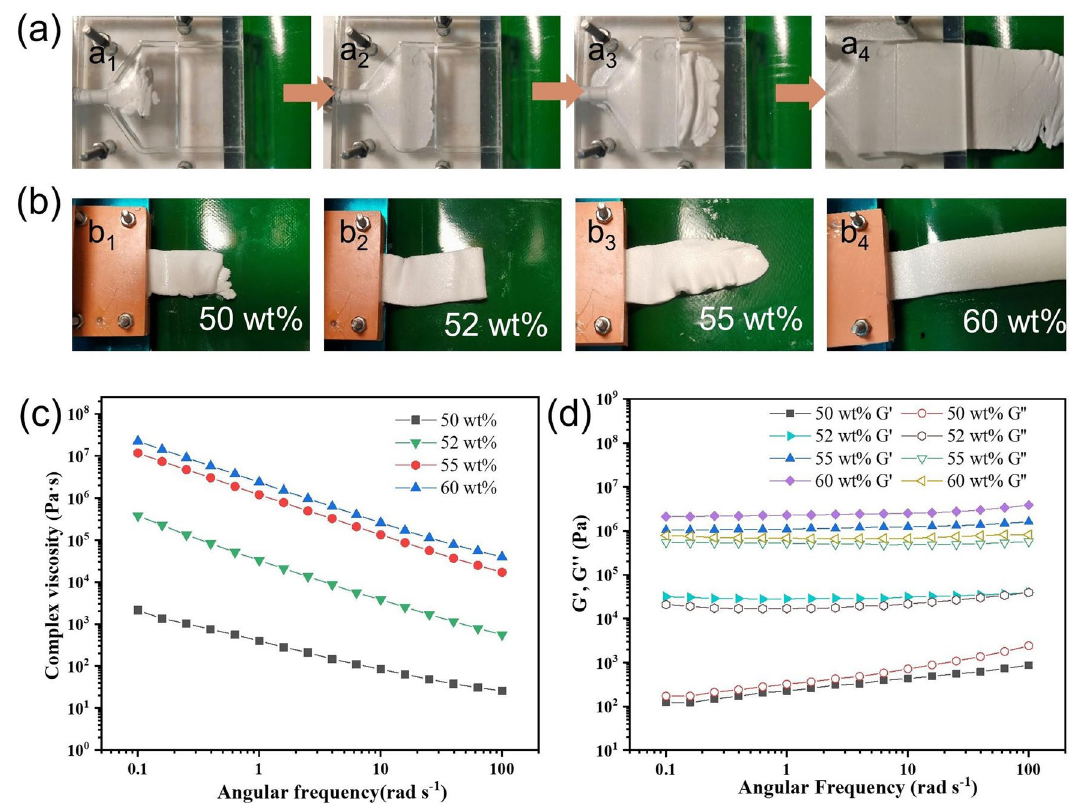
Fig. 4 Rheological properties and processibility of BN/SG inks. a Digital image showing the flowing of 60 wt% BN/SG inks in the expansion mold. b Extruded V-BN/SG strips at different BN contents. Plots of c the complex viscosity and d storage ( G ′ ) and loss ( G ′′ ) moduli as a func- tion of angular